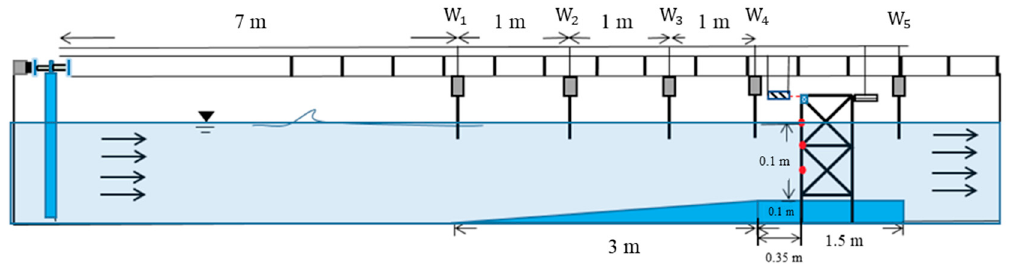
Table 1. Scaled parameters for the model relative to the prototype